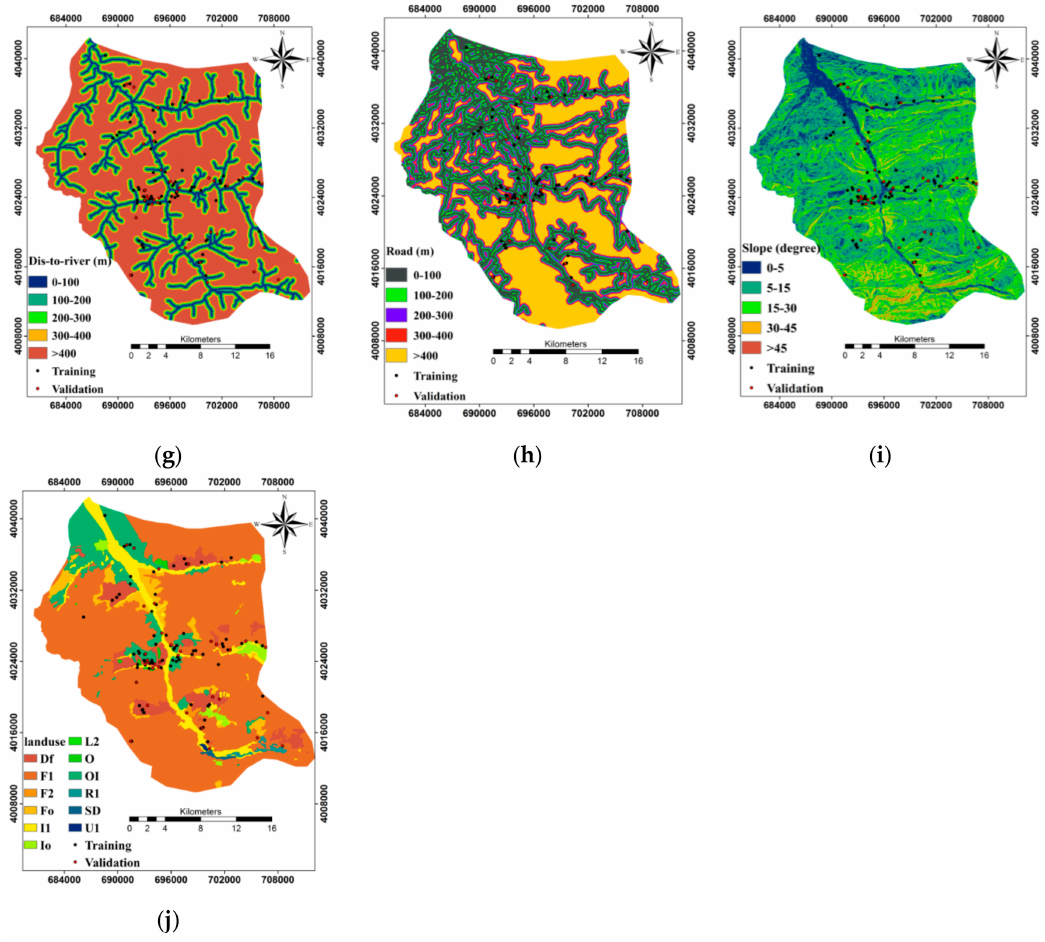
Figure 3. ( a ) Slope aspect, ( b ) curvature, ( c ) elevation, ( d ) distance from the fault, ( e ) lithology, ( f ) NDVI, ( g ) distance from the river, ( h ) distance from the road, ( i ) the slope angle, and ( j ) land